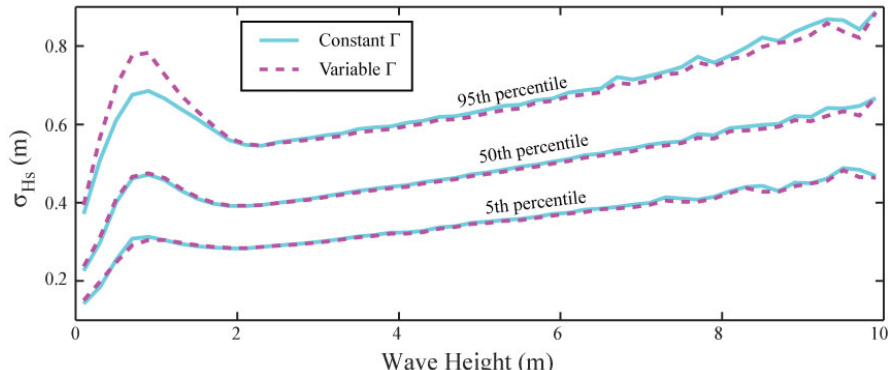
Figure A1. Variation of σ h as a function of Hs for two implementations of the adjustment, firstly using a constant value for Γ and then utilising the functional form displayed in Figure 3a. The various percentiles are calculated for bins 0.2 m